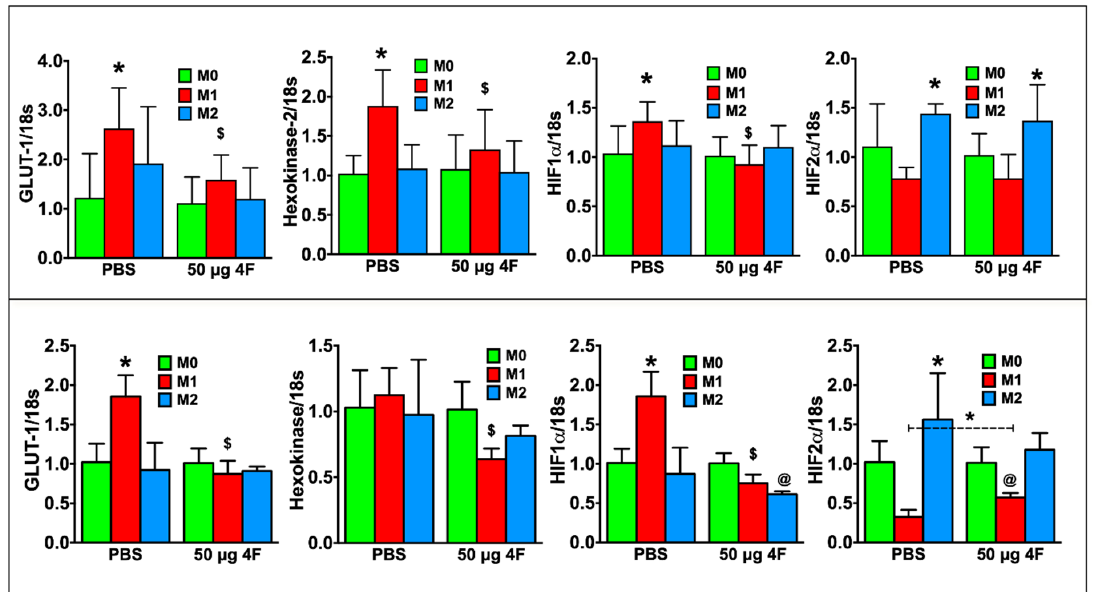
Figure 6. L-4F attenuates M1 macrophage-associated metabolic gene profile in polarized macrophages. RT-PCR analysis of M1-macrophage associated metabolic genes from polarized RAW 264.7 cells (upper panels) or polarized mouse peritoneal macrophages (lower panels) after overnight treatment with either PBS or L-4F (50 µ g / mL). Data are presented as fold changes (mean ± SD) and compared to non-polarized M0 macrophages. * p < 0.05 vs. respective M0; $ p < 0.05 vs. PBS-treated M1 group, @ p < 0.05 vs. respective M0 and M2 groups, n = 3 / group each done in triplicate as in Figure 5.